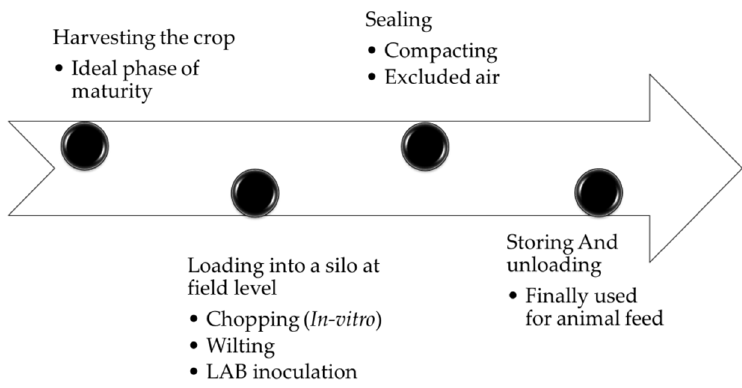
Figure 2. Stages of silage production from different plants.